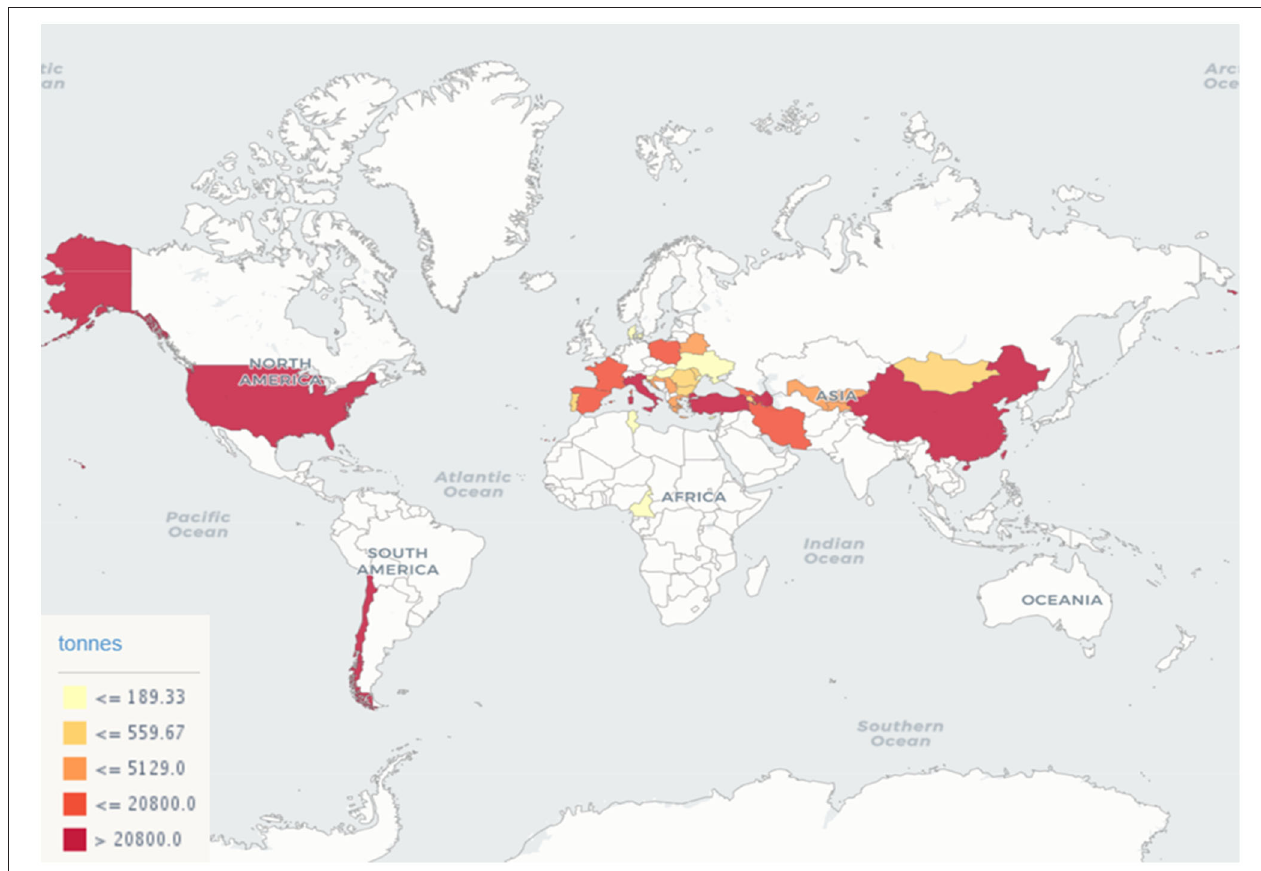
FIGURE 1 | In-shell hazelnut production during the years 2017-2019 according to the FAO.